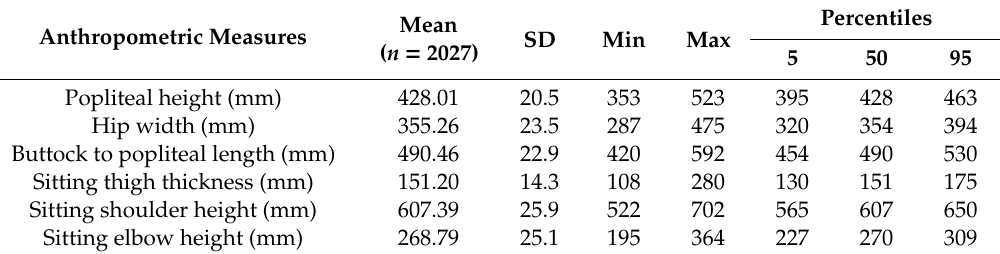
Table 1. Anthropometric measures of Korean males between ages 20 and